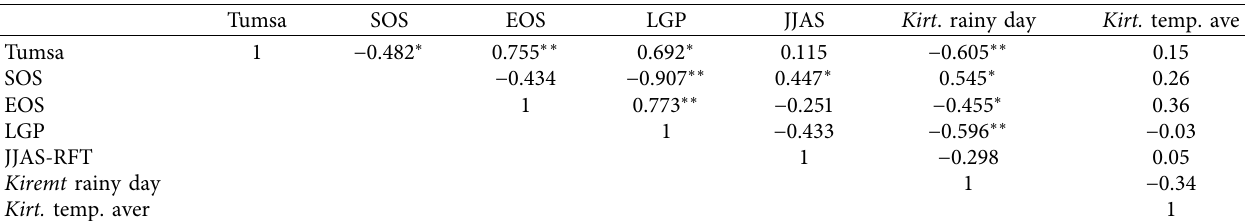
Table 7: Pearson’s upper triangular correlation matrix of Tumsa yield with seasonal rainfall and kiremt average of temperature char- acteristics at Welmera area.